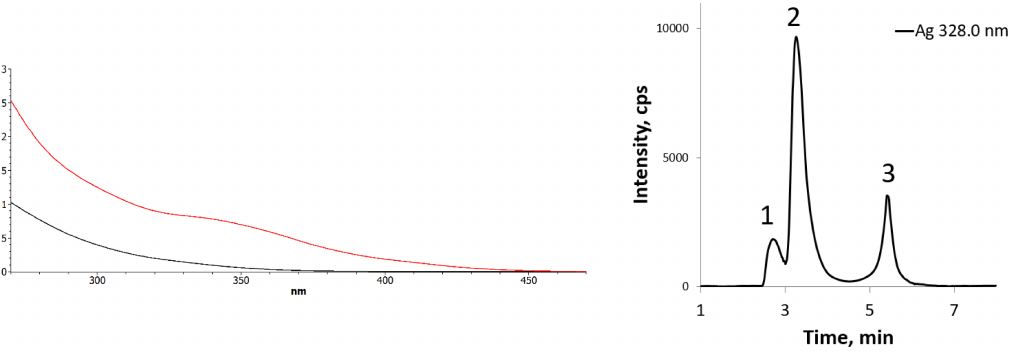
Figure 6. The UV-VIS spectra of the NO 3 − -containing reaction solution (black curve—as synthesized, red curve—aged for 3 months) ( left ); The HPLC-ICP-AES chromatogram of the reaction solution aged for 3 months ( right ). Peaks No.2 and No.3 correspond to silver clusters containing 19 and 20 atoms,